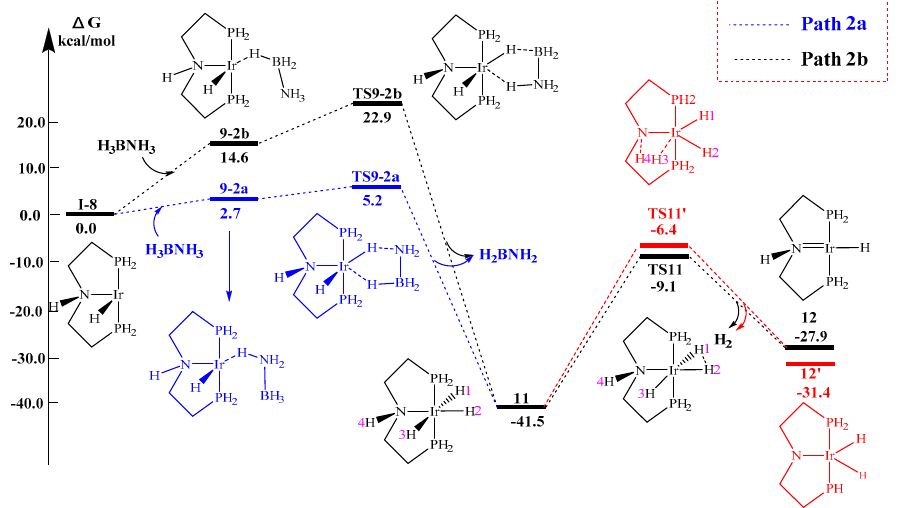
Figure 8. Concerted reaction potential surface starting from intermediate.